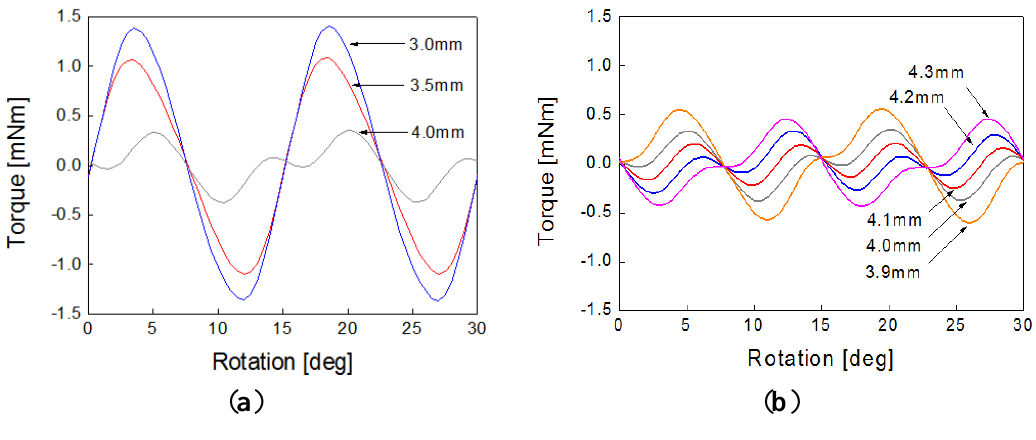
Figure 6. Simulation results of the cogging torque according to the tooth shape: ( a ) initial model and ( b ) proposed